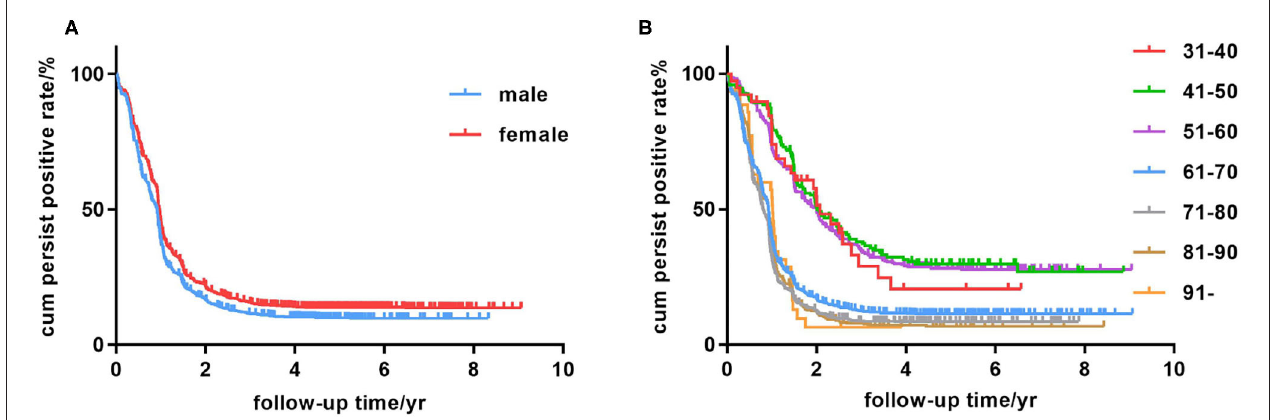
FIGURE 3 | Kaplan-Meier analysis of age group, sex, education level and medical insurance condition. (A) Persistent HBsAg positive rate in the male and female groups. (B) Persistent HBsAg positive rate in the 31- to 40-, 41- to 50-, 51- to 60-, 61- to 70-, 71- to 80-, 81- to 90-year, and 91-year-and-above age groups.